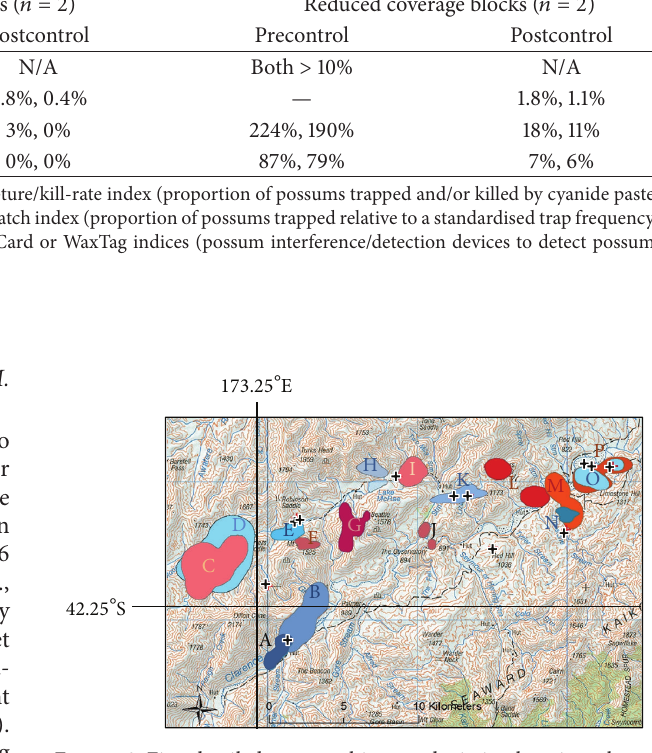
Figure 3: Fine detailed topographic map depicting location, shape, and size of the 95% kernel home ranges calculated from GPS units recovered from 16 purpose-reared sentinel pigs, released onto Molesworth Station and Clarence Reserve. Each individual pig’s home range is depicted by a different colour and letter ( 𝑛 = 16 ). In relation to the areas covered by the GPS-tracked released sentinels, overlaid crosses represent kill locations for 12 confirmed TB-positive pigs (both released sentinels and resident wild pigs) shot during hunting